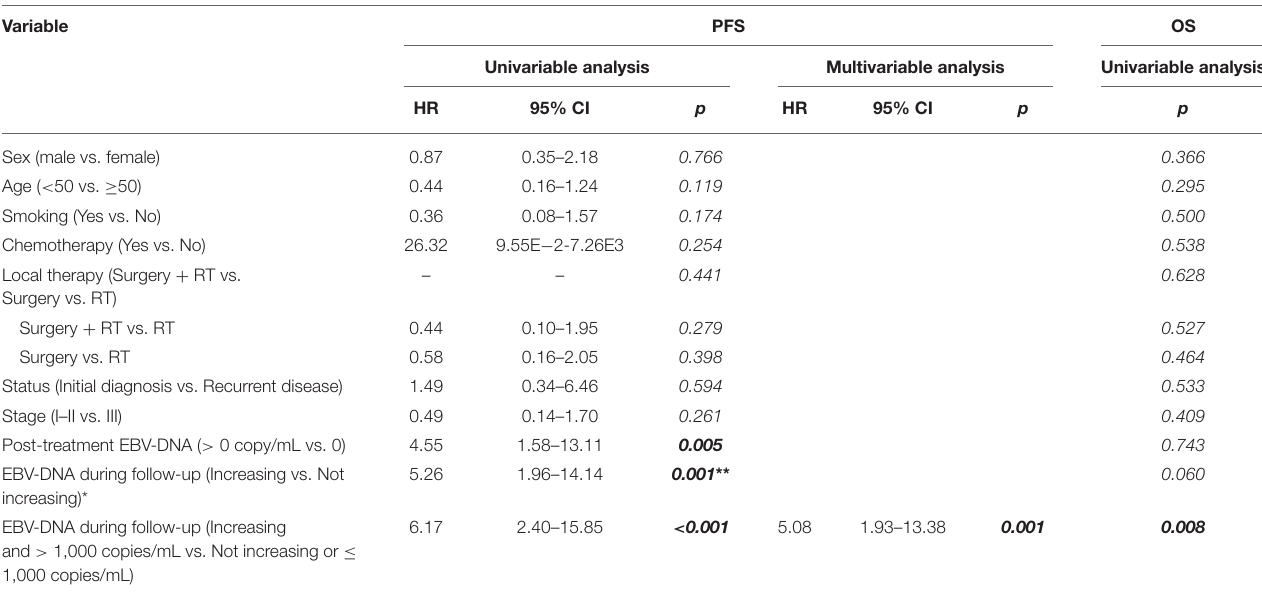
TABLE 4 | Univariable and multivariable Cox regression analyses in the follow-up set.